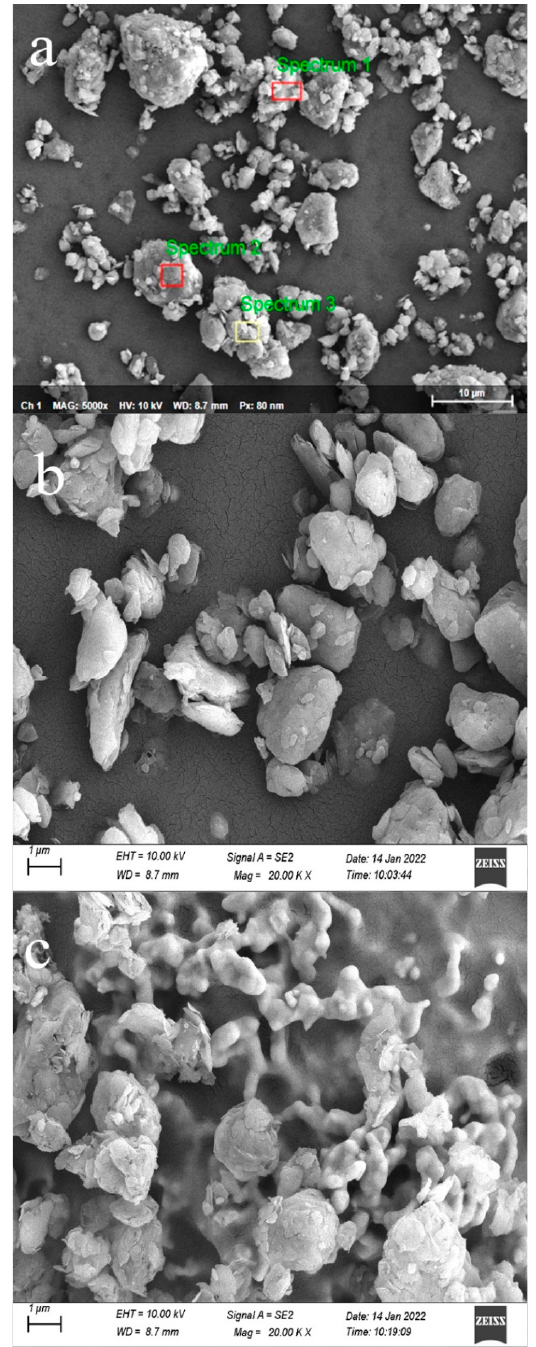
Figure 5. SEM images and EDS analysis of the CG sample ( a ) spot scanning, ( b ) un-calcined CG sample, and ( c ) calcined CG sample under 800 ° C .